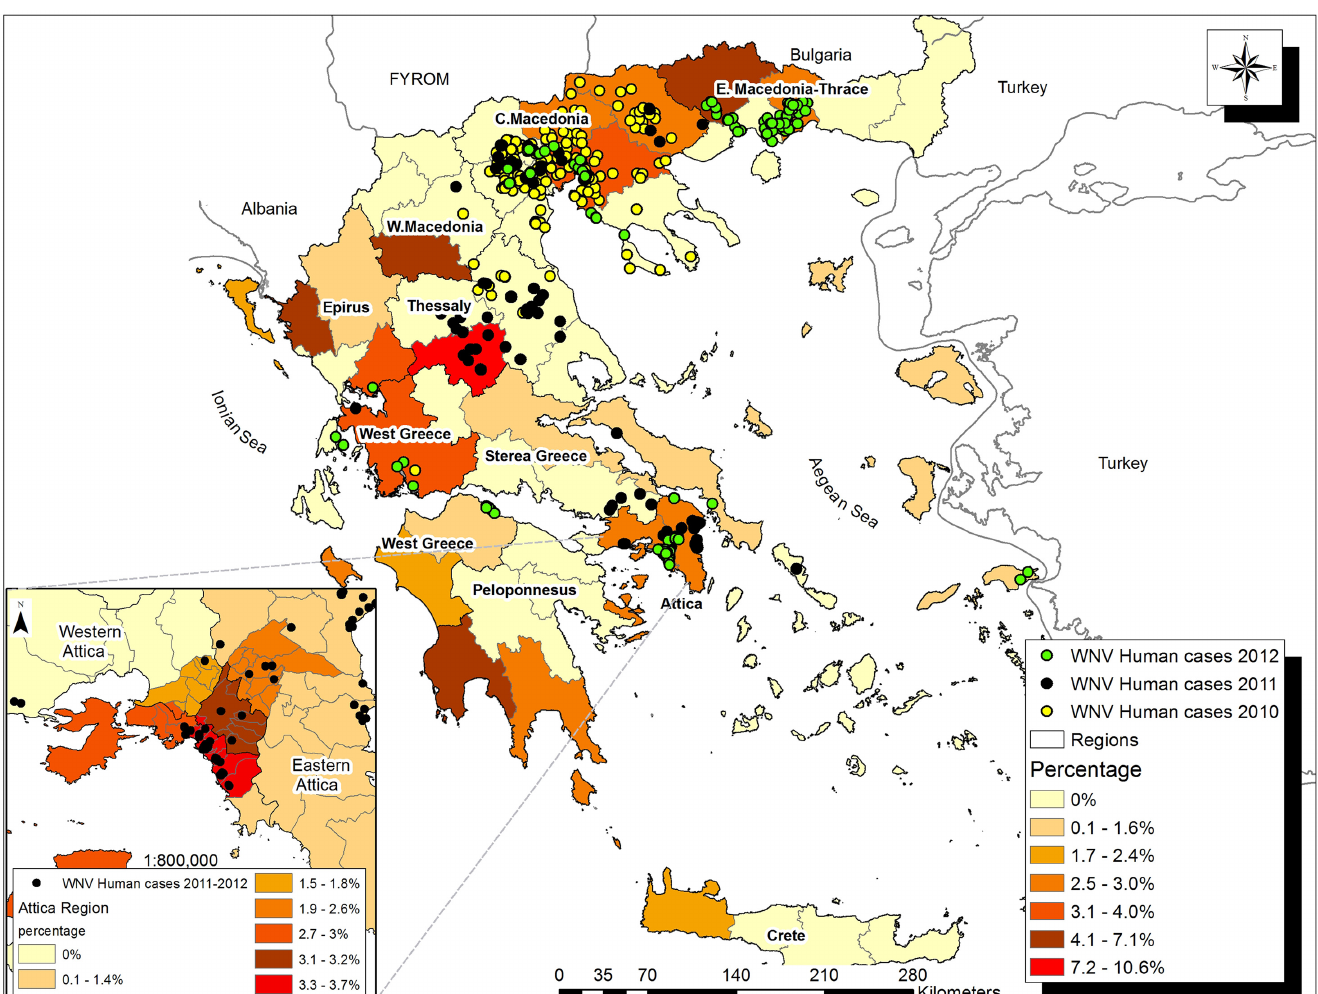
Fig 1. Area map of Greece according to WNV IgG seroprevalence levels (level NUTS 3) together with the geographical distribution of recorded human cases recorded during 2010 –